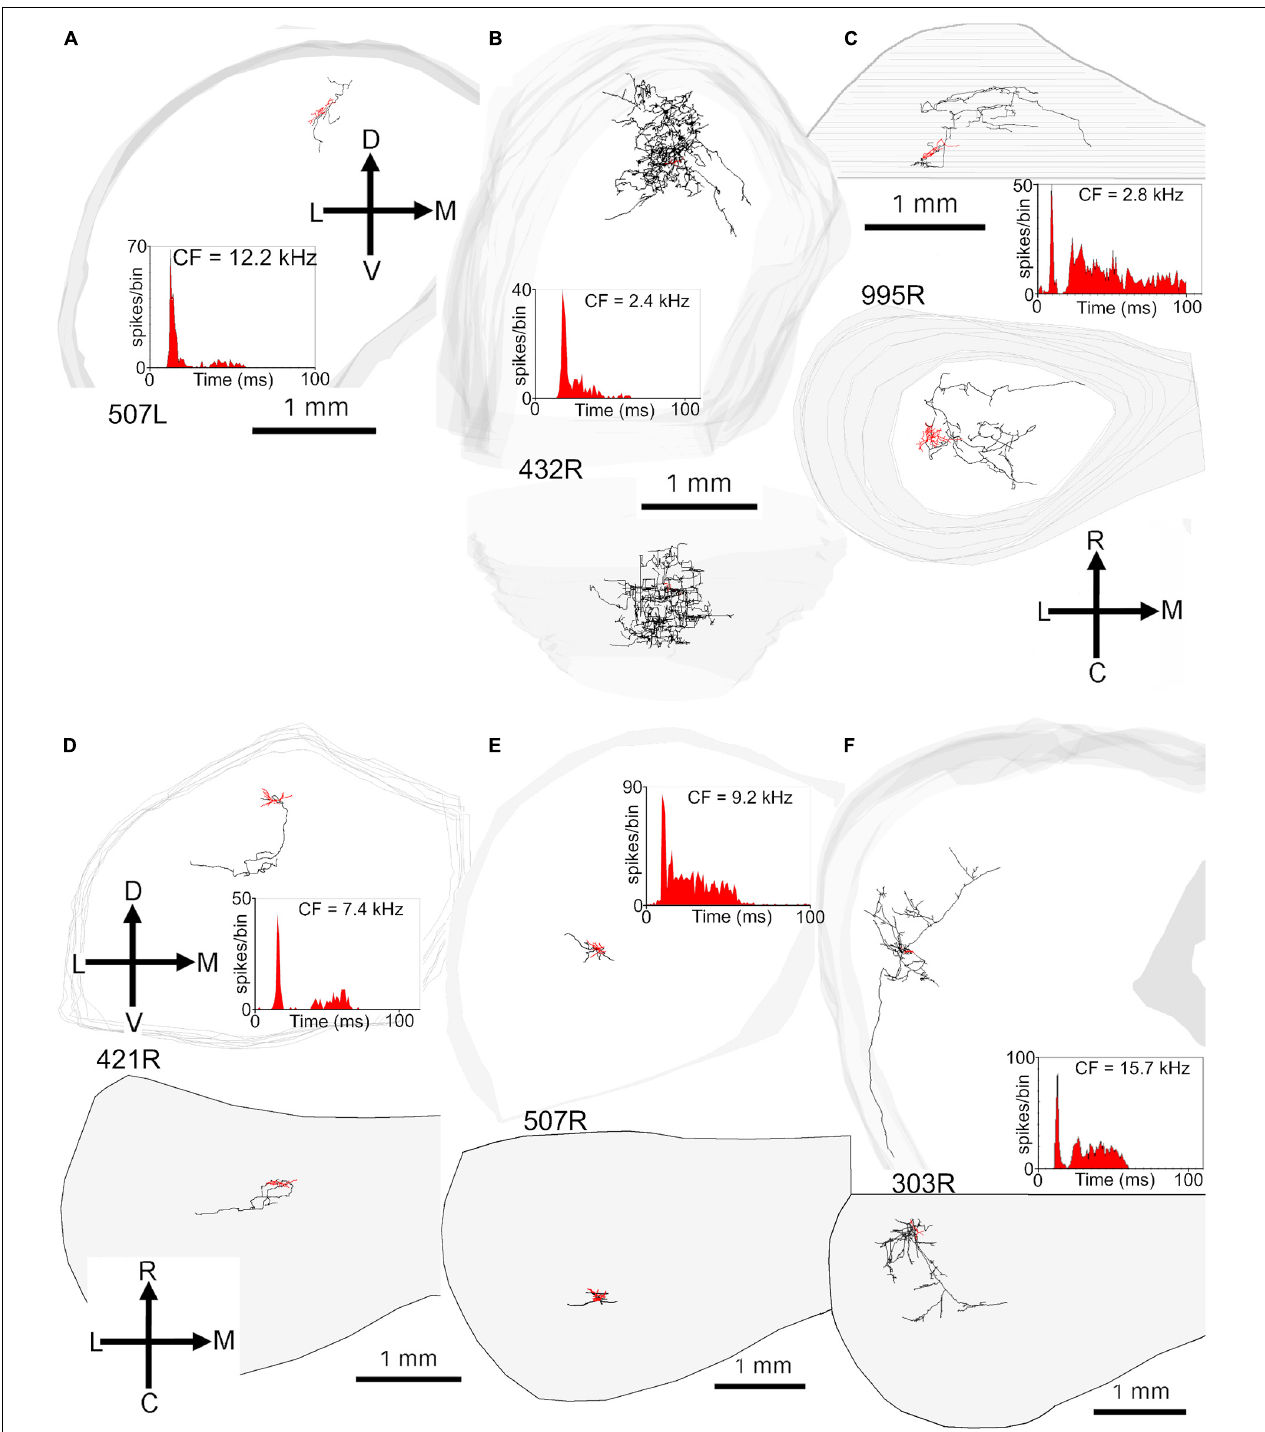
FIGURE 7 | Reconstructions of the axonal ramifications of six onset or on-sustained cells with somata located in the ICc. The cells have varying degrees of pauser-like responses with a reduced response after the onset followed by some degree of recovery. (A) Small, less flat disk cell (onset response) with a short, localized axon that contacts two laminae. (B) Small ovoid, less flat cell with a dense axonal arbor that stretches across many laminae in the ICc and also into the dorsal cortex. (C) Large flat disk cell with dendrites confined to one lamina but with an axon that traverses at least three laminae. (D) Small ovoid stellate cell with an axon that terminates in a lamina that is ventral to the one containing the soma. (E) Small ovoid stellate cell with a very short axon that is oriented roughly perpendicular to the axis of the laminae. (F) Small flat ovoid cell located at the lateral edge of ICc with an axon that terminates in a number of laminae as well as the lateral cortex and then enters the